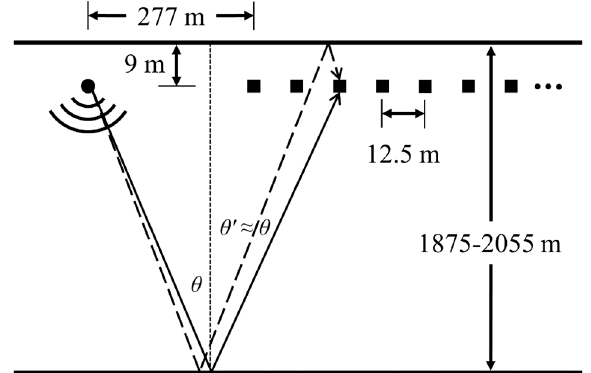
Figure 1. ( a ) Layout of the COAST experiment from Holbrook et al. [29], conducted off the coast of Washington state in July 2012. Each line represents the ship’s path while towing an ~8 km streamer with 636 receivers spaced 12.5 m and a source array of 36 airguns at 4.5 knots. The white arrow indicates the beginning of the analyzed transect. Data were collected by coordinated firing of the airgun array approximately every 50 m and recording for 16.384 s. ( b ) The bathymetry of transect 10 is shown here as a function of the ship location with blue indicating the ship location for the analyzed signal pulses.